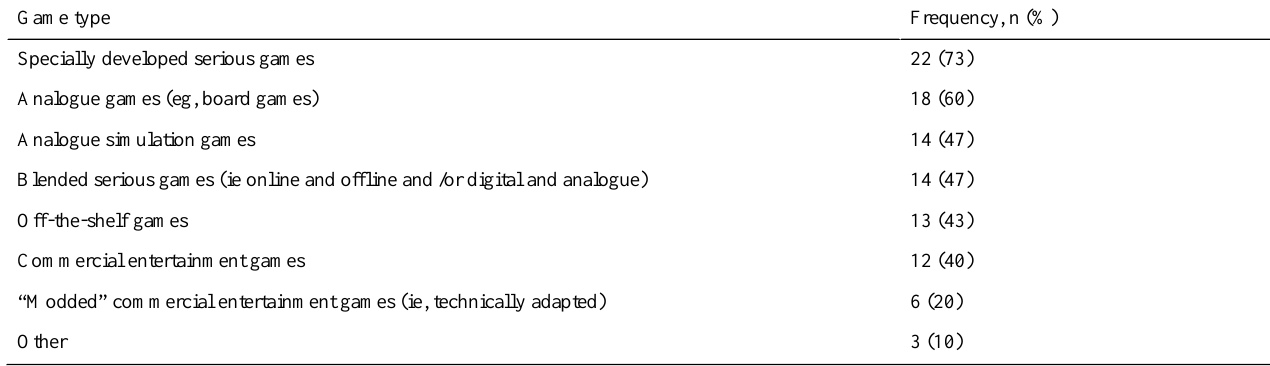
Table 1. Game types facilitated (multiple selections per respondent; N=30).